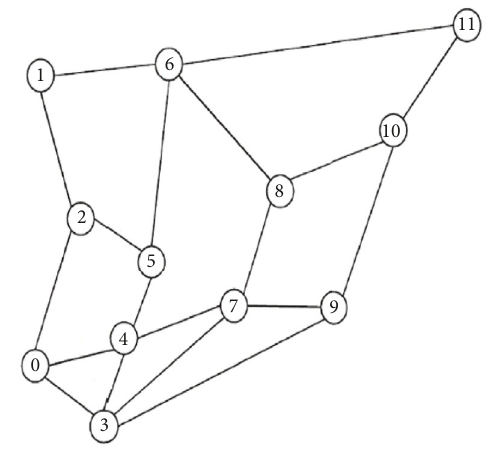
Figure 8: Germany topology with 17 nodes and 26 fiber